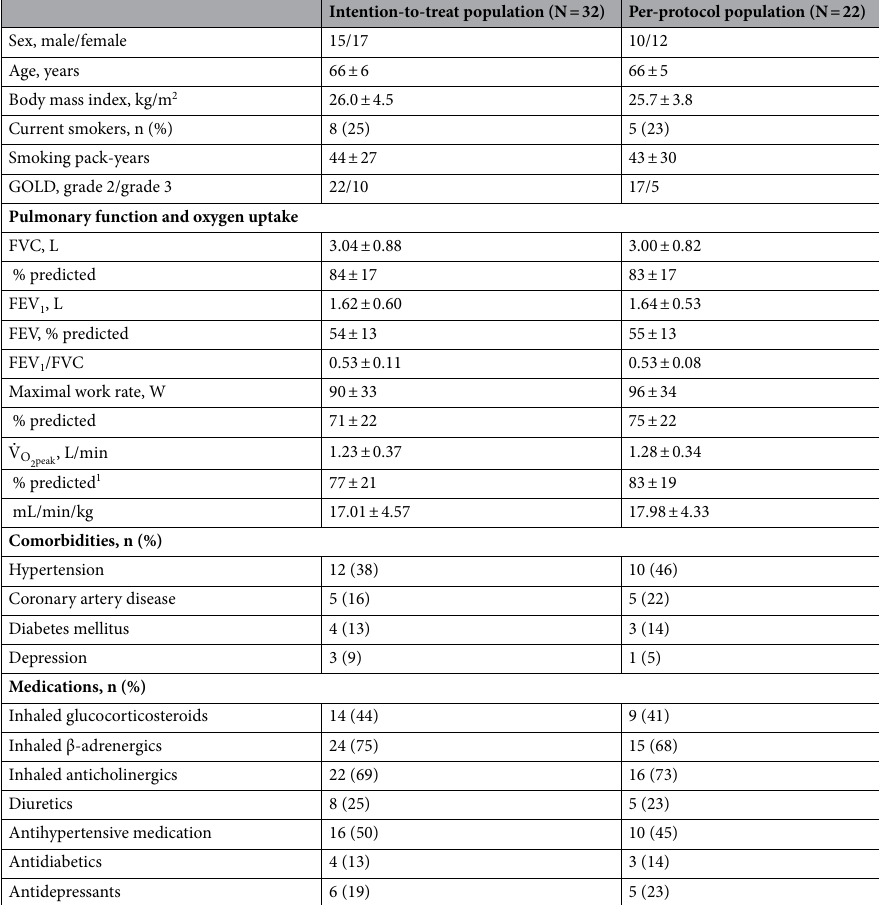
Table 1. Patient characteristics. Values are numbers (proportion) or mean ± SD. 1 Normal values